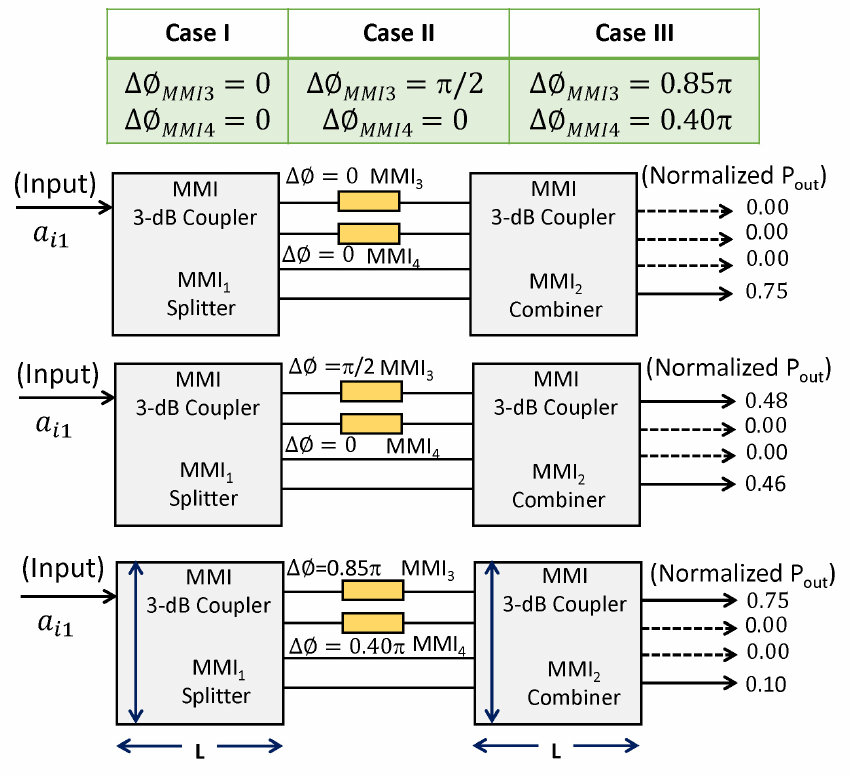
Figure 5. Cascaded MMI devices as tunable optical switches. Case I: The input is fed through a i 1 ∆ φ ∆ φ ∆ φ ∆ φ MMI 3 = MMI 3 = π /2 and MMI 4 = 0, Case II: MMI 4 = 0, and Case III): ∆ φ MMI 4 = 0.4 π . The dark bold arrows indicate the light input and output positions and the numbers are the normalized optical